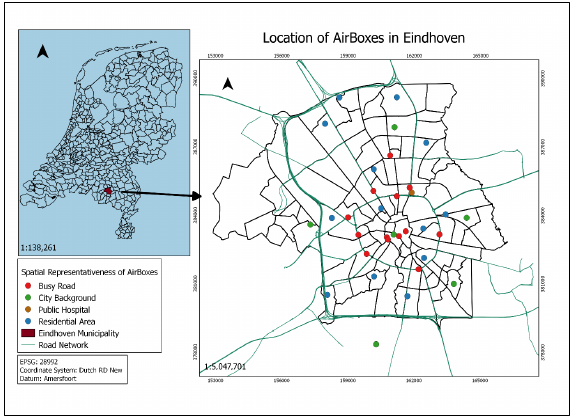
Figure 3 Spatial representativeness of ILM network in Eindhoven Figure 1. Location of airboxes in Eindhoven